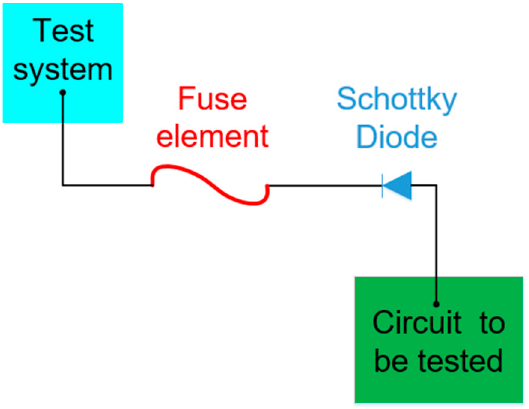
Figure 5. The 2.5D integrated circuit test system for the silicon interposer.